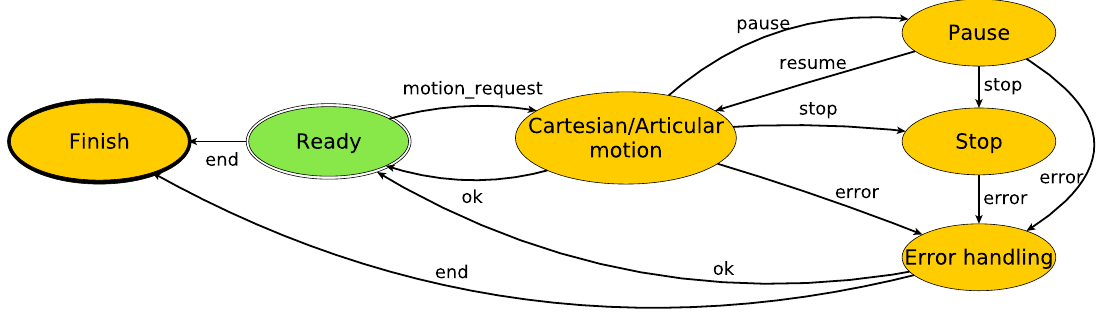
Figure 4. Proposed state machine-based architecture in detail. The figure shows existing states and transitions.